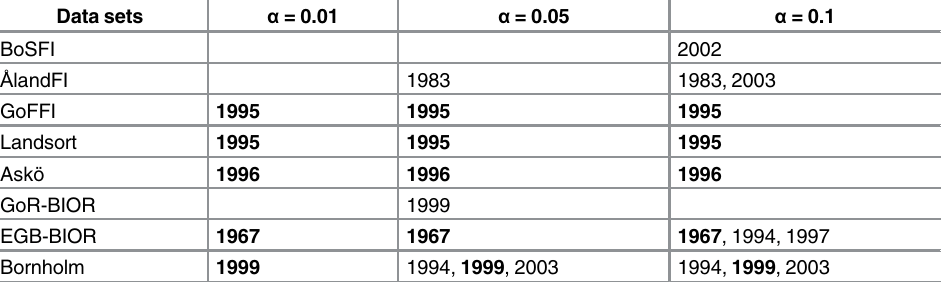
Table 4. Shifts in zooplankton community structure (year) that were detected for different α levels using the indicator time series (only entire datasets with more than 12 years of observations were considered). No community shifts were detected for the Bothnian Bay (BoBFI) data. Years that were consis- tently detected at all levels of α are in bold. Data sets α = 0.01 α =